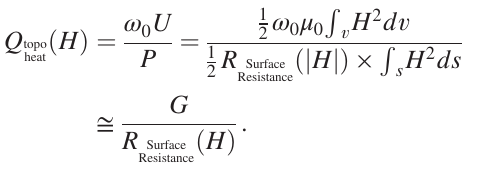
FIG. 16. Simulated effective rf surface resistance with peak H field of BCP- and EP-treated fine grain Nb surfaces, including representative constant-temperature superconducting state losses.